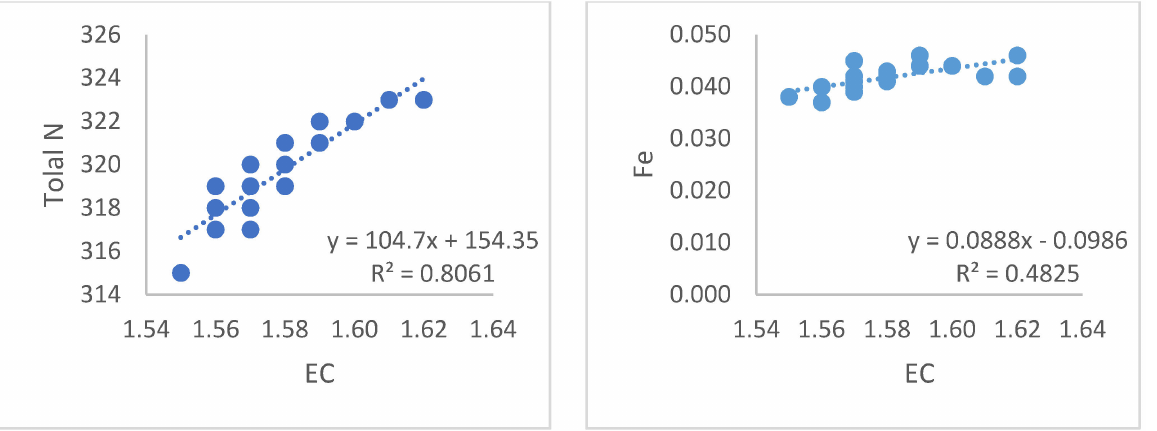
Figure 5. Relationships between the EC values and the pH and DO values of the liquid in the system.